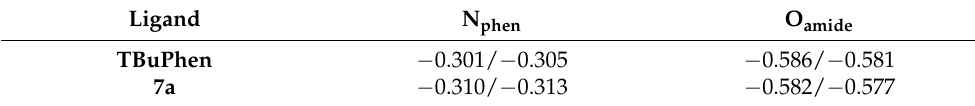
Figure 7. ESP maps of TBuPhen and 7a in two projections. Table 2. NBO charges of N Phen and O amide of TBuPhen and 7a